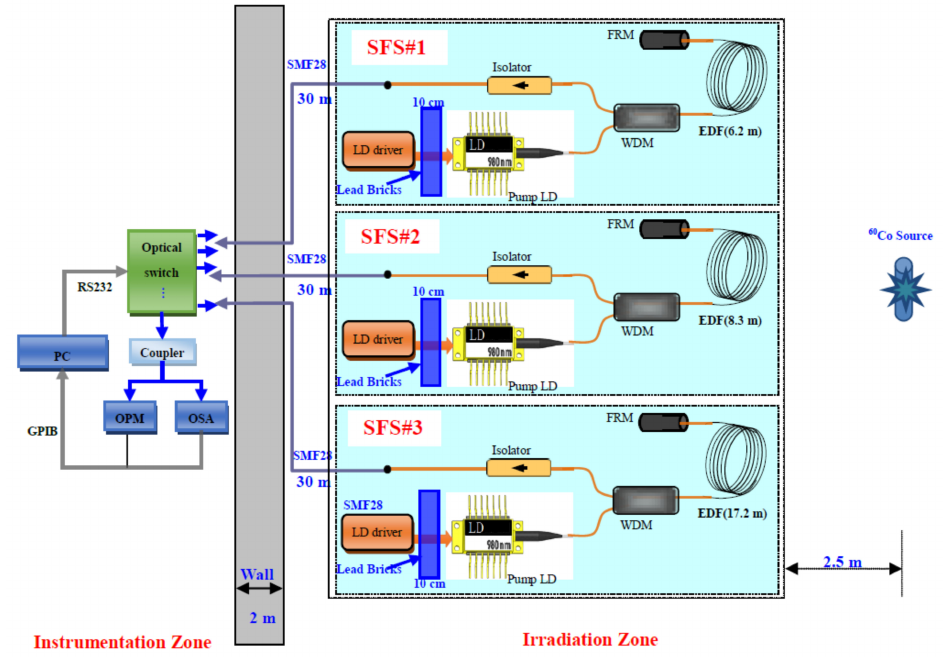
Figure 1. Experimental setup of SFS under Gamma irradiation.